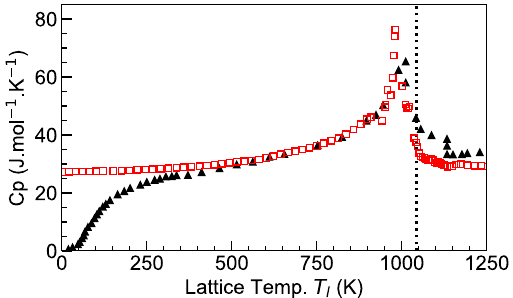
Fig. 1 Constant pressure heat capacity of α -iron versus tempera- ture. The black triangles denote experimental measurements 87,88 , the red squares our simulation results, and black dashed line indicates the experimental Curie transition temperature. This illustrates the well-known ferromagnetic – paramagnetic phase tran- sition, where the heat capacity diverges at the Curie temperature.